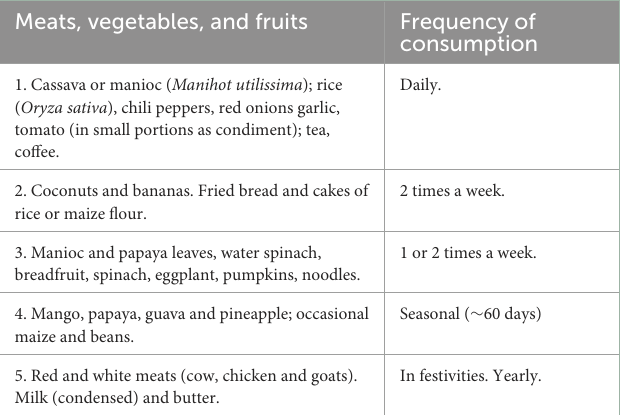
TABLE 2 Frequency of food consumption by item